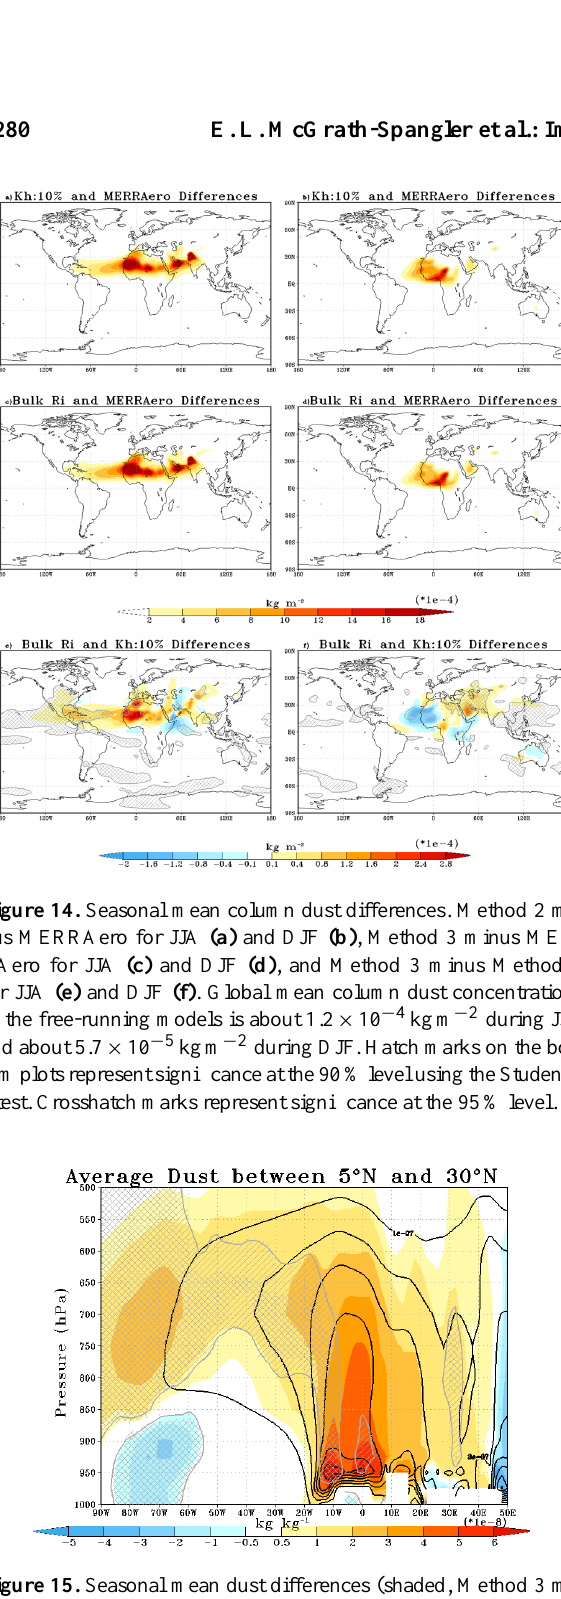
Figure 15. Seasonal mean dust differences (shaded, Method 3 mi- nus Method 2) and mean dust concentration (black contours) for JJA averaged from 5 to 30 ◦ N. Average concentration is about 1.6 × 10 − 7 kgkg − 1 . Hatch marks represent significance at the 90% level using the Student’s t test. Crosshatch marks represent signifi- cance at the 95% level.